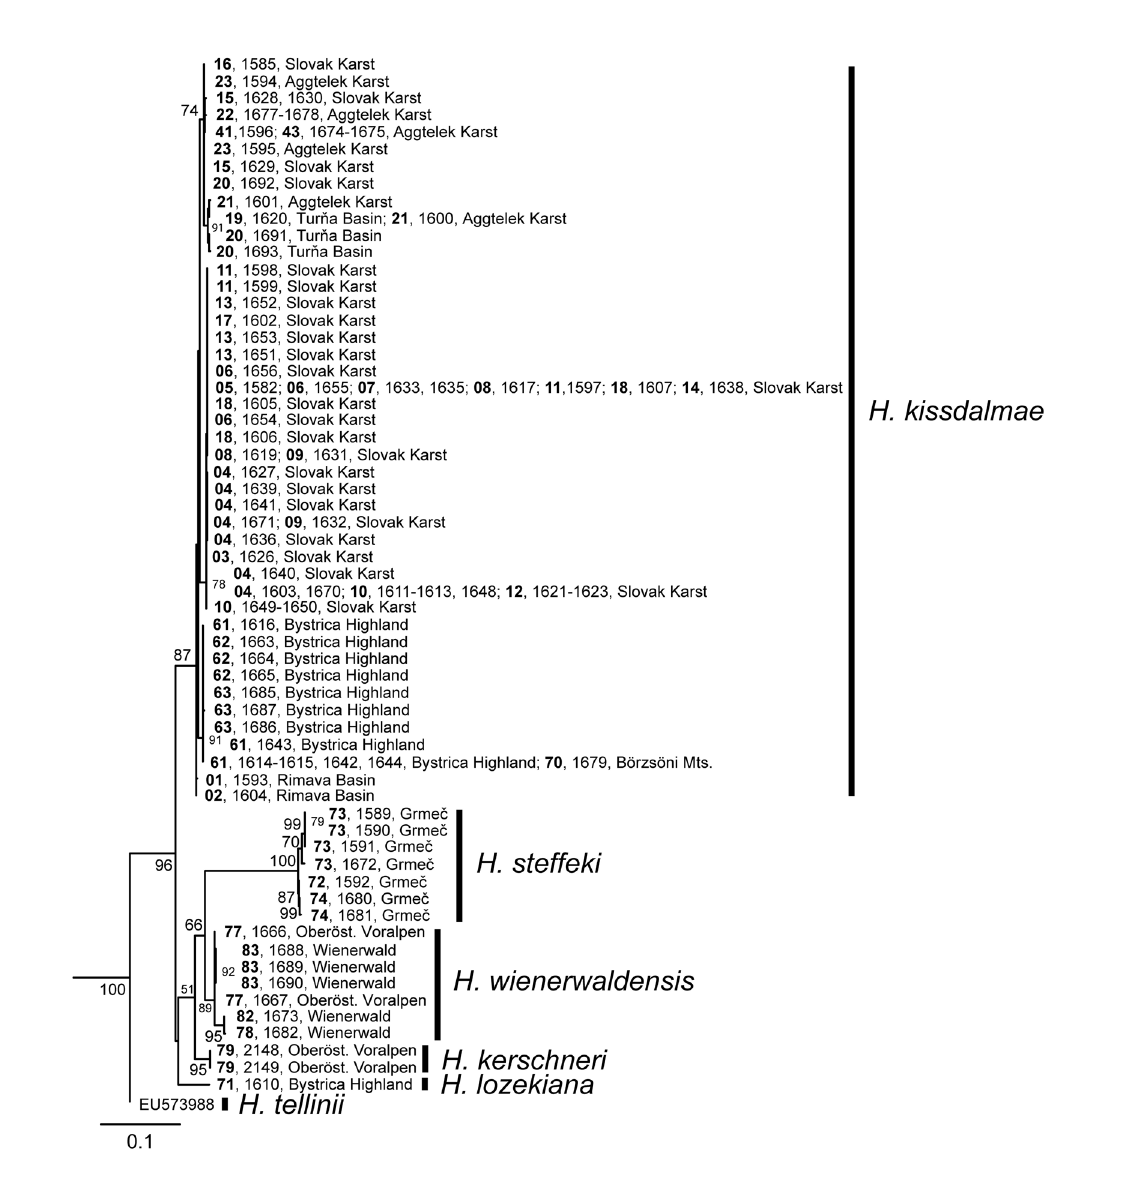
Fig. 7. Phylogenetic tree from maximum likelihood analysis in W-IQ-TREE based on 16S rRNA and ITS2 (outgroup pruned off). Specimens identified by two-digit locality code in bold, four digit individual DNA code, and orographic unit (see Table 1) or GenBank accession number (from Ponder et al. 2008); bootstrap support values at nodes > 50; not given for extremely short nodes within H. kissdalmae Erőss & Petró, 2008 and H. wienerwaldensis Haase, 1992; scale bar in substitutions per